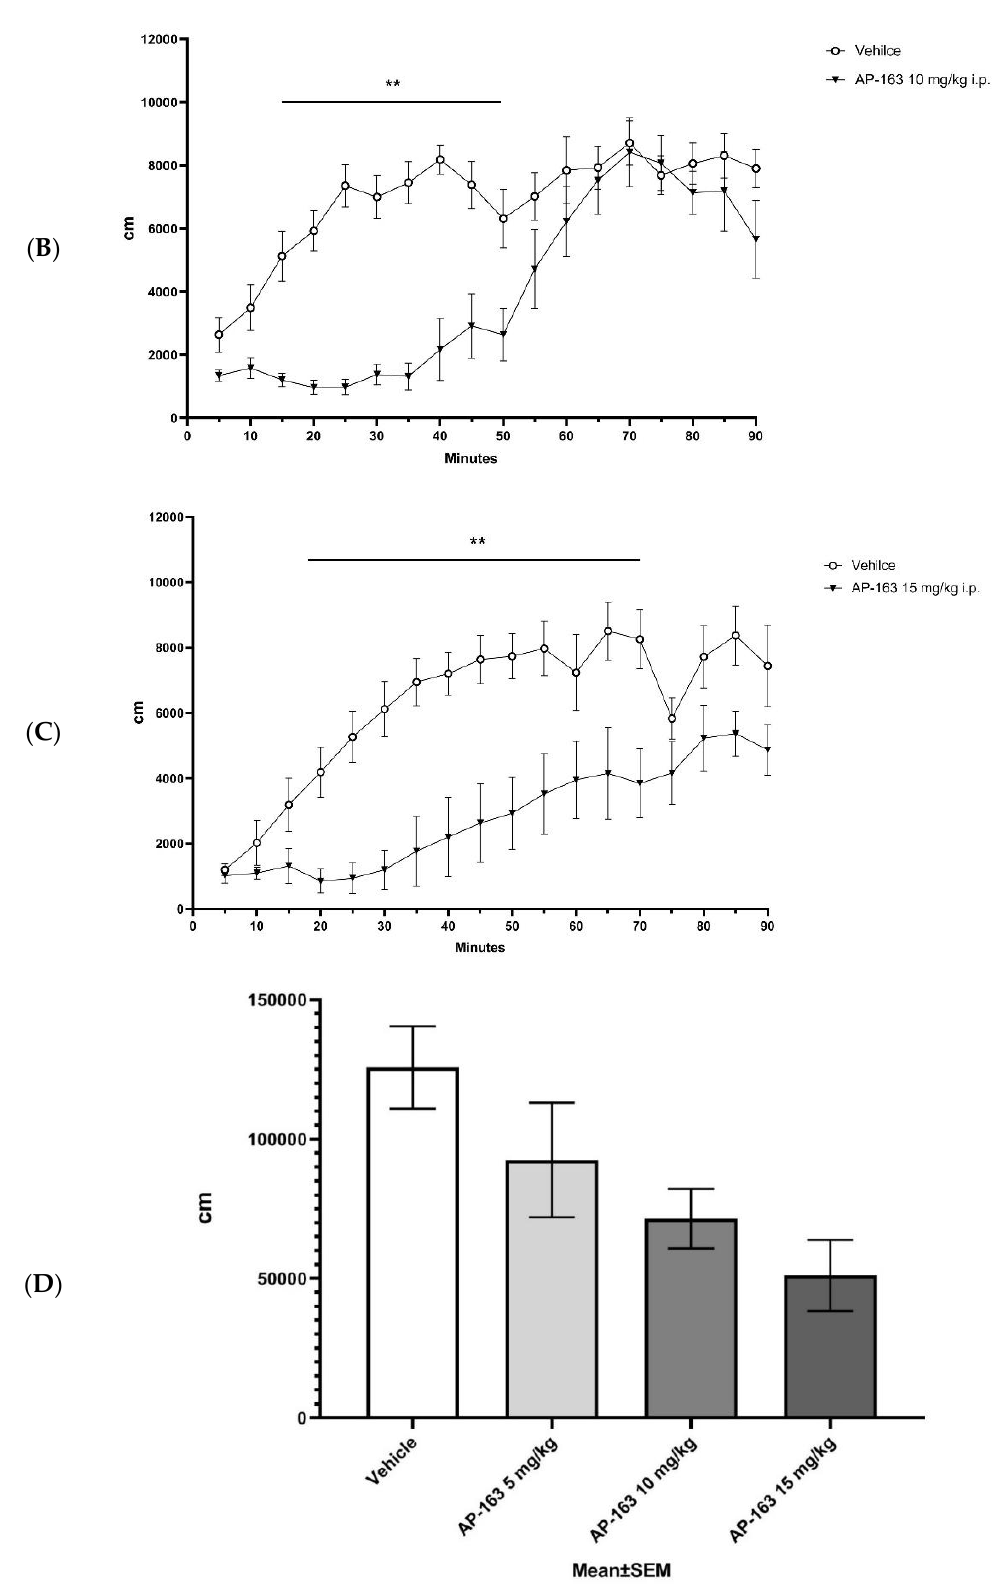
Figure 6. Effect of compound 18 (AP163) on the dynamics of hyperlocomotion of DAT-KO rats at doses ( A ) 5 mg/kg, ( B ) 10 mg/kg and ( C ) 15 mg/kg, and ( D ) the cumulative graph comparing the locomotion (total distance traveled for 90 min after i.p. administration) of the three treatment groups relative to vehicle-treated control group. * p < 0.05; ** p < 0.01.